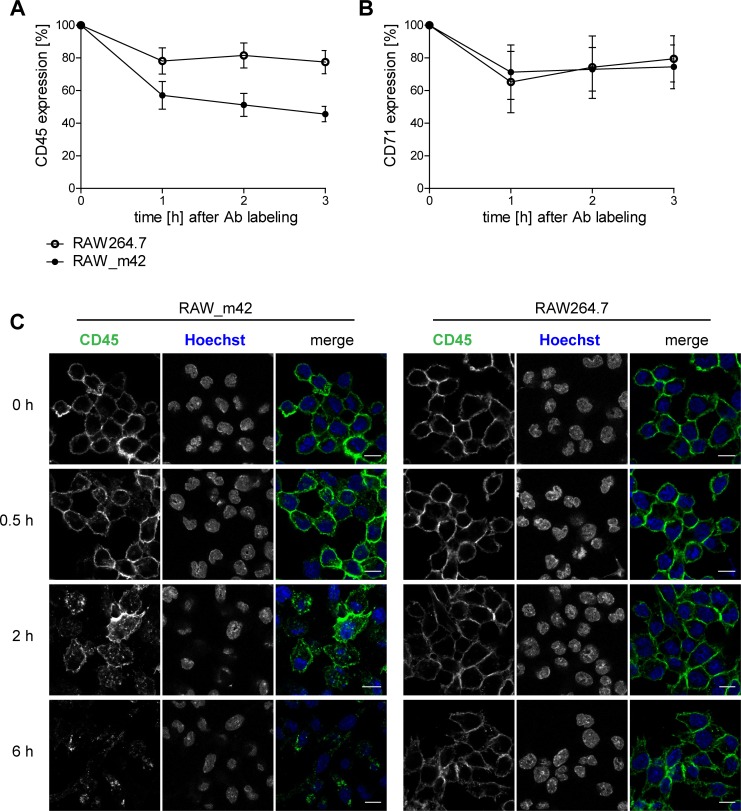
CD45 is internalized from the plasma membrane in m42-expressing cells.(A, B) An internalization assay for CD45 was set up by surface labelling RAW264.7 and RAW_m42 cells with primary Abs directed against CD45 (A) or CD71 (B). Cells were then incubated at 37°C for the indicated time periods, followed by labeling of the primary Ab that remained at the cell surface with corresponding PE-conjugated secondary Abs and flow cytometric analysis. The mean fluorescence intensity of the CD45 and CD71 signals was normalized to the values for time point 0. Results represent mean percentages ± SD of 4 independent experiments. (C) Representative images indicating localization of CD45 in RAW264.7 or RAW_m42 cells after Ab labeling of surface-resident CD45 and cultivation of the cells for the time periods are shown. After fixation and permeabilization of the cells, Ab-labelled CD45 molecules were stained with Alexa647-conjugated secondary Ab and visualized by confocal laser scanning microscopy. Cell nuclei were stained with Hoechst dye. Scale bars, 10 μm.